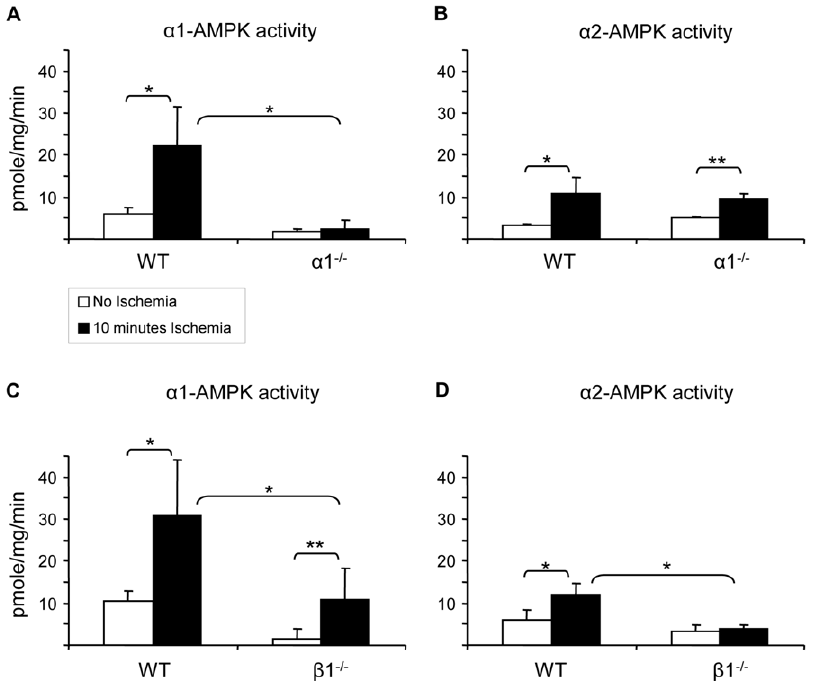
Figure 1. AMPK activation by acute renal ischemia in wild type, AMPK- a 1 2 / 2 and AMPK- b 1 2 / 2 mice. Lysates (1 mg protein) from control ( % no ischemia) and ischemic ( & 10 min ischemia) kidneys of WT (C57Bl/6), AMPK- a 1 2 / 2 and AMPK- b 1 2 / 2 mice were immunoprecipitated with antibodies specific for the a 1 and a 2 AMPK catalytic subunits (n=6–8 per group). Results are shown as mean 6 SD. In WT mice AMPK activity was increased by acute renal ischaemia (P , 0.001). In AMPK- b 1 2 / 2 mice, AMPK activity after acute renal ischaemia was reduced compared to WT for both AMPK- a 1 (P , 0.001) and AMPK- a 2 (P , 0.001) isoforms. In AMPK- a 1 2 / 2 mice there was no activation of AMPK- a 1 by acute renal ischemia, whereas AMPK- a 2 was activated by acute renal ischemia (P , 0.01) by an amount not different to WT. * P , 0.001, ** P ,